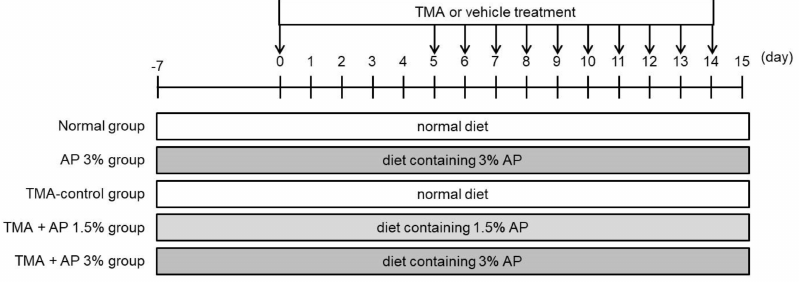
Figure 1. Experimental